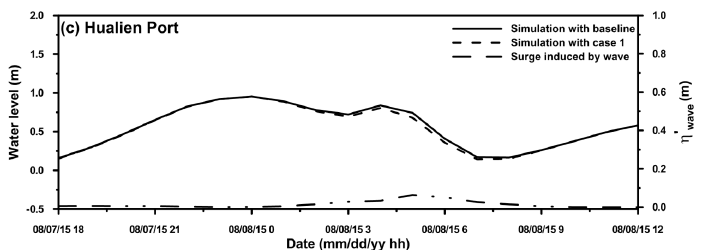
Figure 8. Comparison of the simulated water level between the baseline and Case 1 and calculated wave-induced surge at: ( a ) Keelung Port; ( b ) Suao Port; and ( c ) Hualien Port during Typhoon Soudelor (2015).